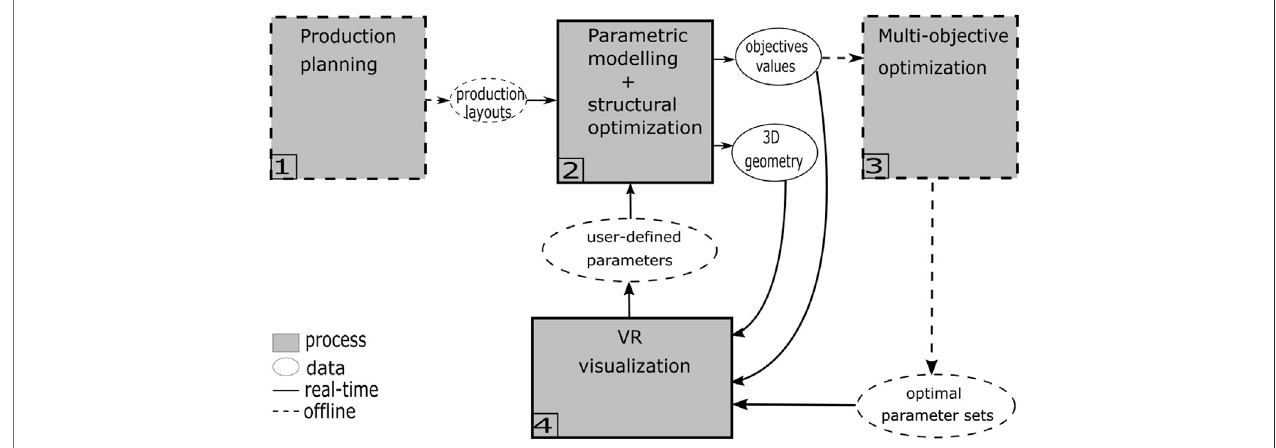
FIGURE 2 | Automated processes and connections between them in BIMFlexi. Abbreviations: MOO, Multi-objective